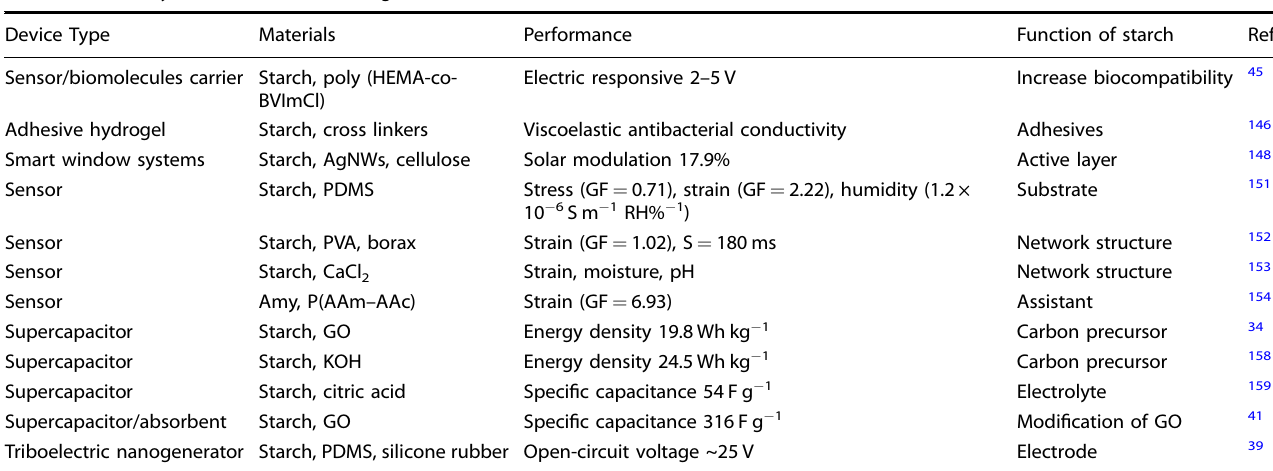
Table 2. Summary of FEs based on starch